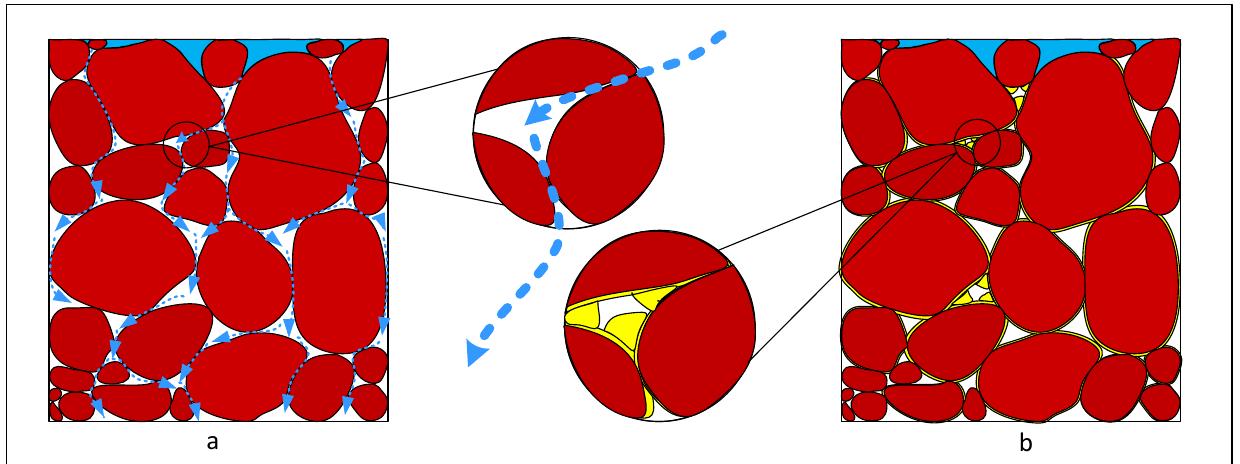
Figure 3. Schematic representation of soil mass: ( a ) Flow paths allowing water to percolate through soil mass. ( b ) Representation of the blockage of pore throats by calcite precipitation and the formation of calcite biofilms on soil grains, leading to narrowing/blockage of flow paths and reducing permeability after biotreatment.